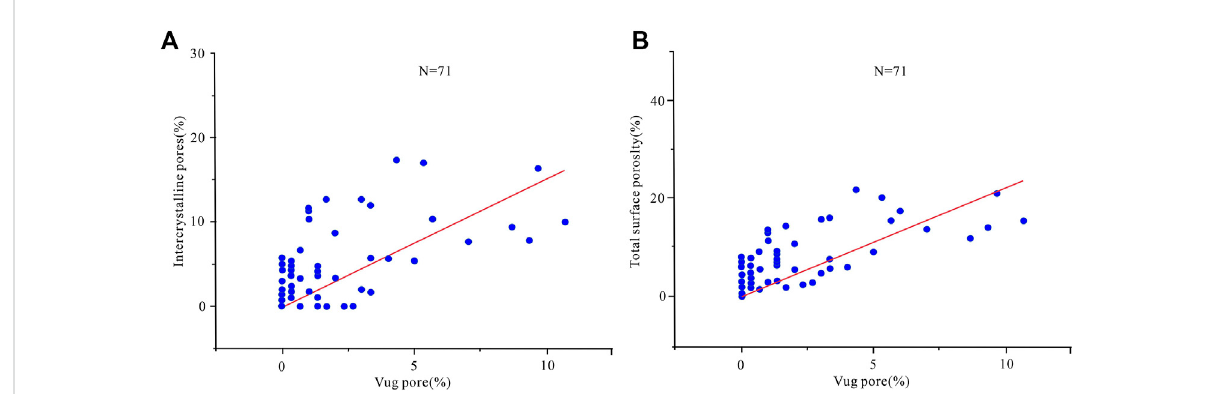
FIGURE 8 Relationship between dissolution pores and surfaceporosity of Cambrian reservoirs in Tarim Basin (A) Intercrystalline pore vs. dissolution pore; (B) total surface porosity vs. dissolution pore.